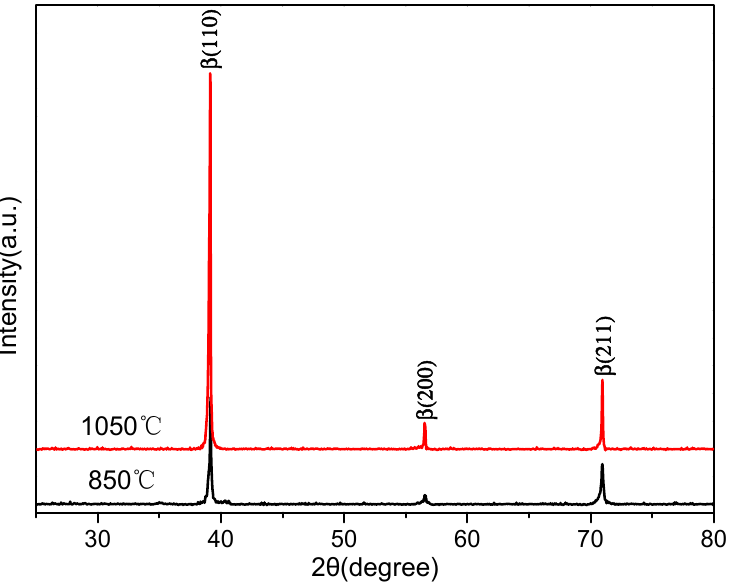
Figure 3. XRD patterns of the alloy solution-treated at 850 and 1050 °C.